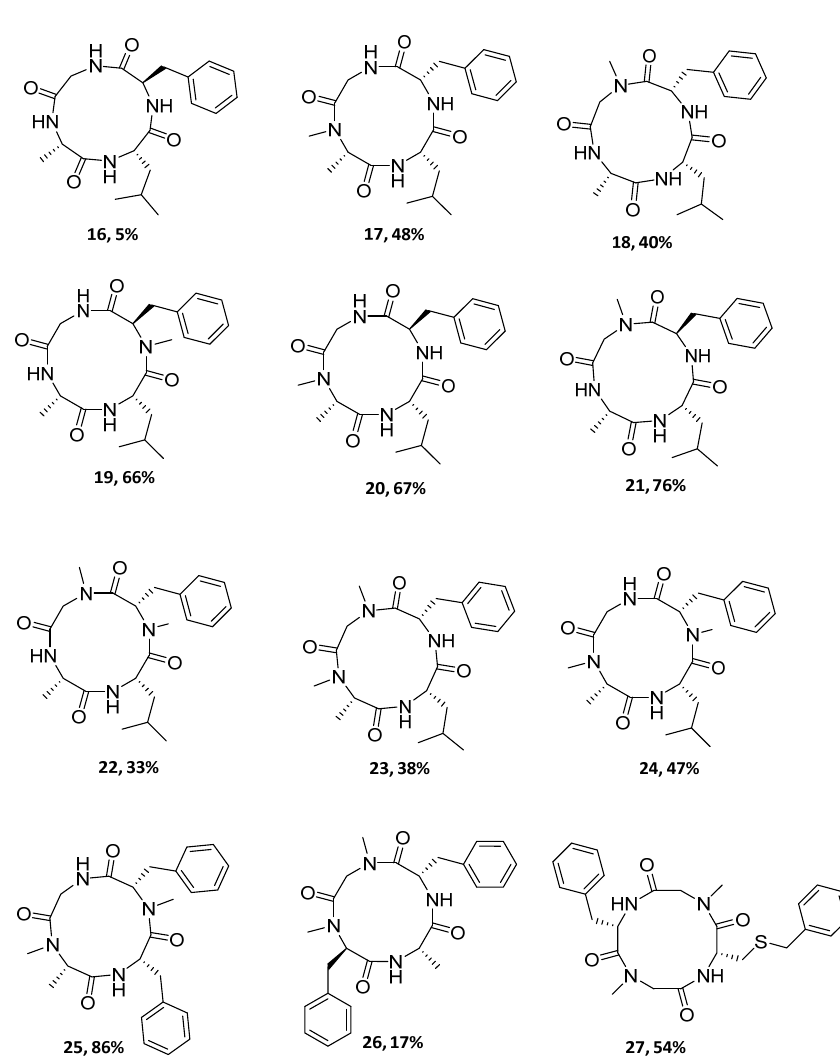
Figure 2. Structures and yields of the synthesized cyclopeptides.